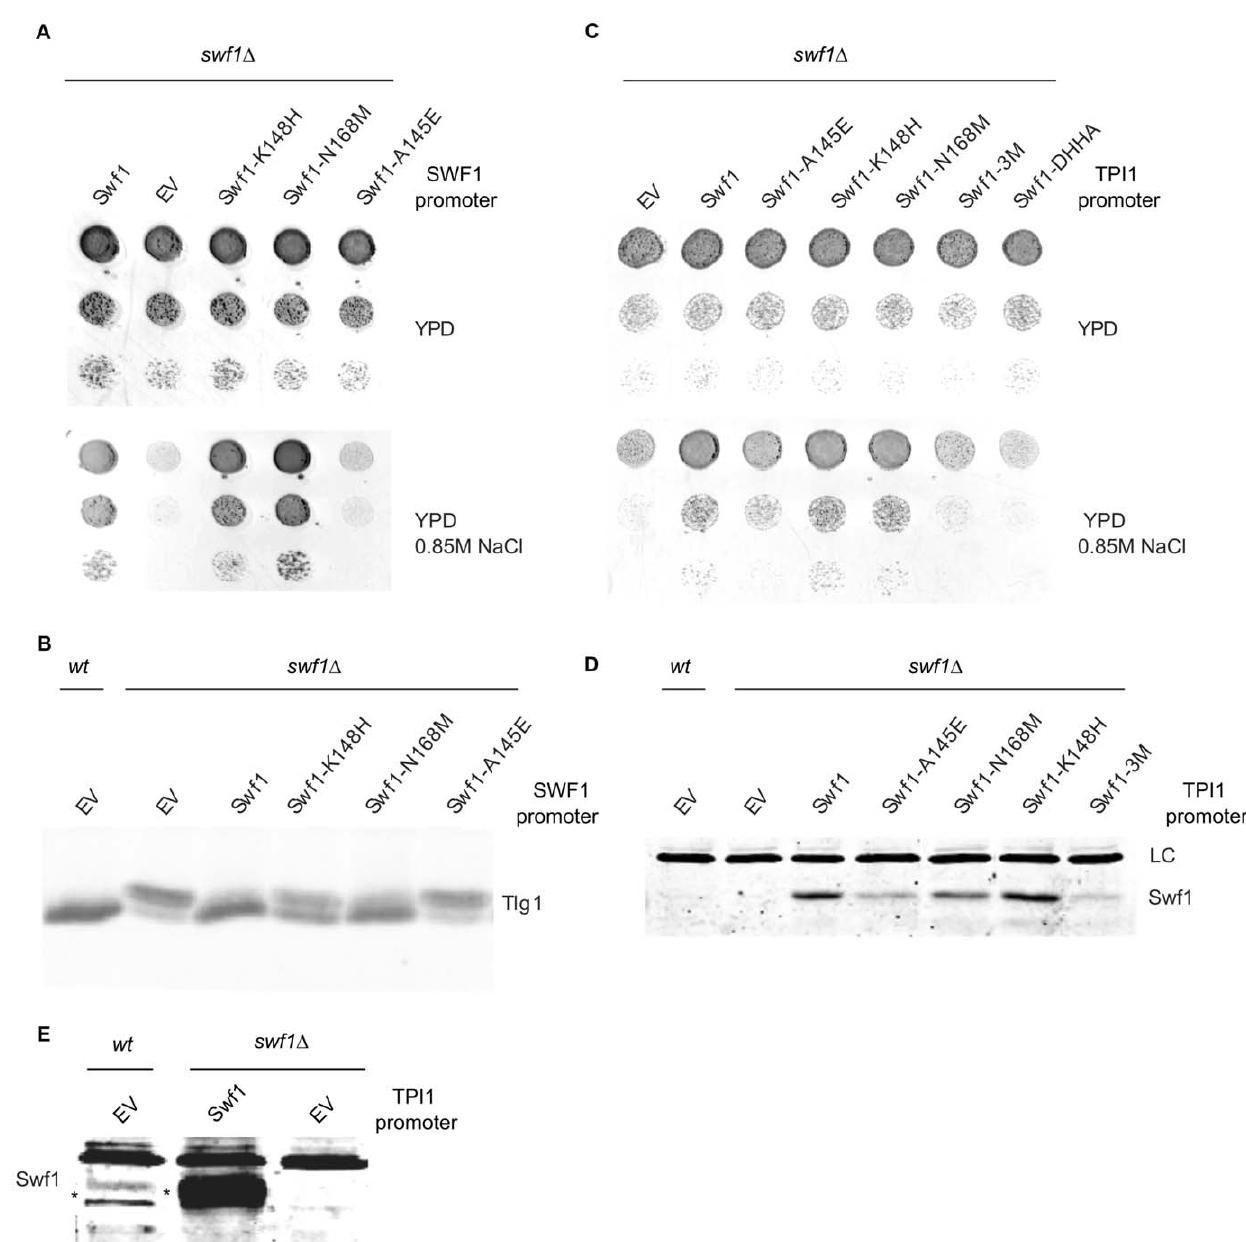
Figure 6. Mutation of the three top scoring SDPs in Swf1 to residues present in Pfa4. A . Serial dilutions of a swf1 D strain transformed with an empty vector (EV), with wt SWF1, or with versions of Swf1 mutated in the highest scoring SDPs to the residues present in Pfa4 all driven by the endogenous promoter . Transformants were grown in solid rich medium containing glucose (YPD, upper panel) or in medium supplemented with 0.85 M NaCl (YPD 0.85 M NaCl, lower panel). B . Western blot of membrane proteins from a swf1 D strain transformed with an empty vector (EV), wt Swf1 or swf1 alleles mutated in the three highest scoring SDPs, to equivalent residues present in Pfa4. The samples were treated with Biotin-BMCC, which biotinylates unpalmitoylated cysteines, resulting in slower migration. Blot was probed using anti Tlg1 antibodies. C . Serial dilutions of a wt strain or a swf1 D strain transformed with an empty vector (EV), wt Swf1, or with versions of Swf1 mutated in the highest scoring SDPs to equivalent residues present in Pfa4, driven by the TPI1 promoter . Swf1-3M contains all three highest scoring SDPs mutated. Swf1-DHHA mutant is assumed to be catalytically inactive. Transformants were grown in solid rich medium containing glucose (YPD, upper panel) or in medium supplemented with 0.85 M NaCl (YPD 0.85 M NaCl, lower panel). D . Western blot analysis of membrane extracts from a wt strain transformed with an empty vector (EV) or a swf1 D strain transformed with an empty vector or with TPI1 promoter driven wt or SDP Swf1 mutants. It was developed using anti Swf1 antibodies. Endogenous Swf1 is not detected under these conditions. A non-specific band is shown as a loading control (LC). E . Western blot analysis of a wt strain transformed with an empty vector (EV), and a swf1 D strain transformed with an empty vector (EV) or TPI1 promoter driven Swf1. The blot was developed using anti Swf1 antibodies, and overexposed to allow for detection of endogenous Swf1.